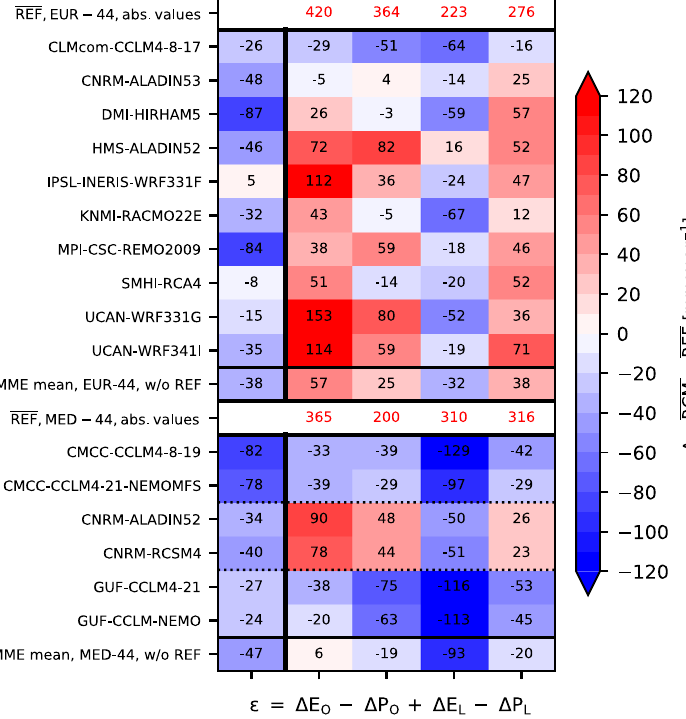
prescribed by the boundary conditions and SSTs in case of the RCMs. In this way, all mass balance deviations and variations in the superimposed div Q LO , with varying mass import and export, can be accounted for conceptually. To assess, which component, P or E , contributes to the overall atmospheric water budget, differences among REF and MME are calculated